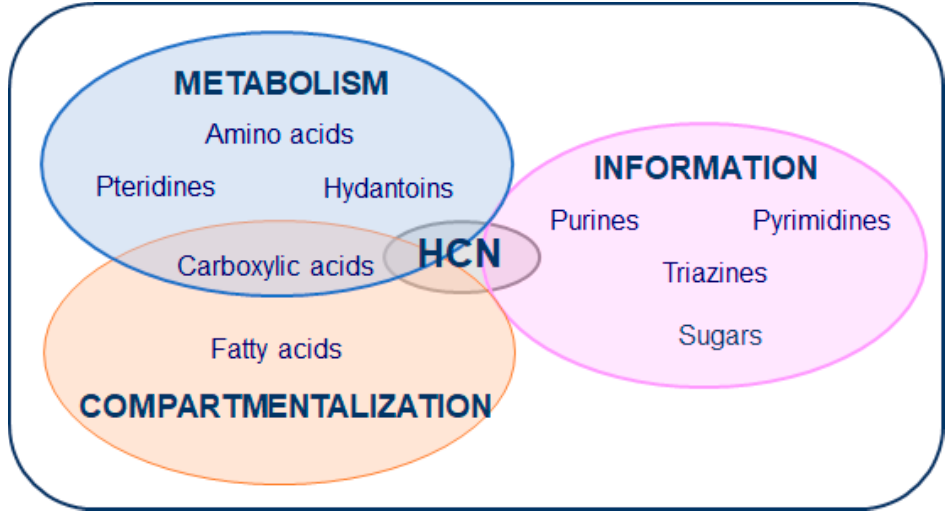
Figure 2. HCN is a key molecule in the simultaneous development of primaeval protometabolic, informational and compartmentalization systems.